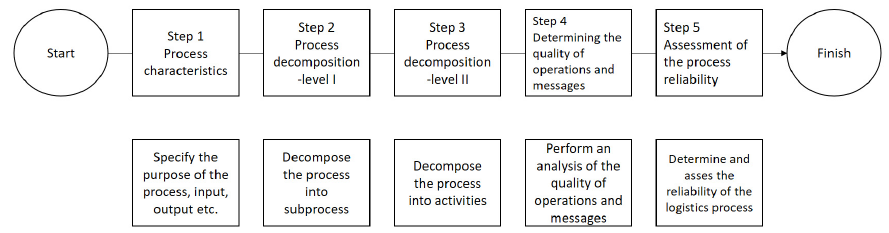
Figure 3. Algorithm of the process reliability assessment method.